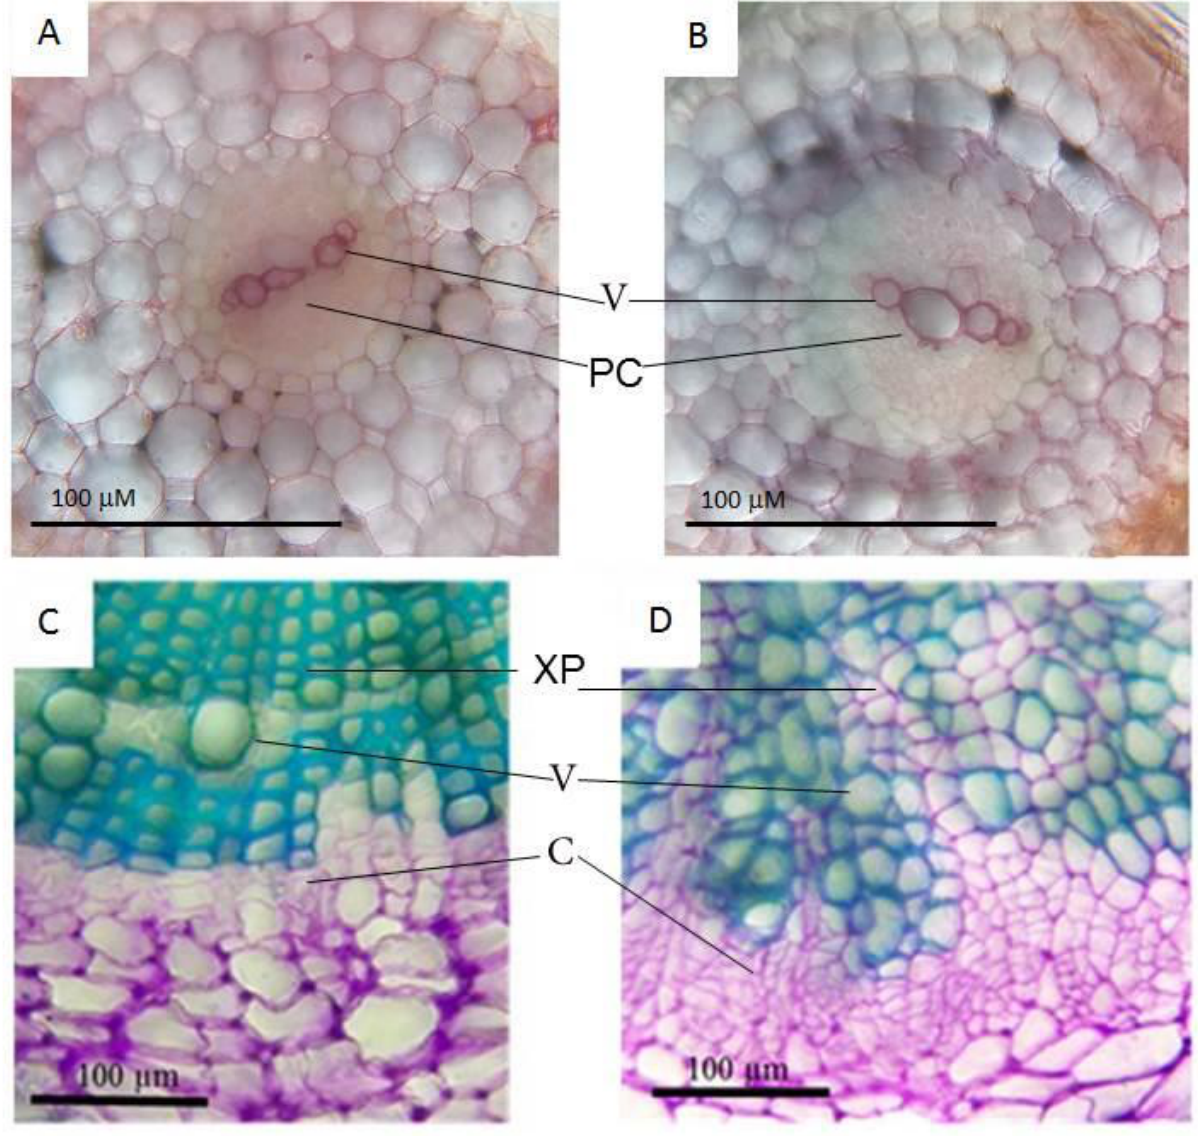
Figure 5. Anatomy of 35S:RsCLE41-1 roots in comparison with 35S:GUS roots of radish. (A) — 35S:RsCLE41-1 roots (7 days old); (B) — 35S:GUS 1 roots (7 days old); (C) — 35S:RsCLE41-1 roots (30 days old); (D) — 35S:GUS 1 roots (30 days old). C and D correspond to Figure 3 in [11]. PC — procambium; C — cambium; V — vessels; XP — xylem parenchyma.